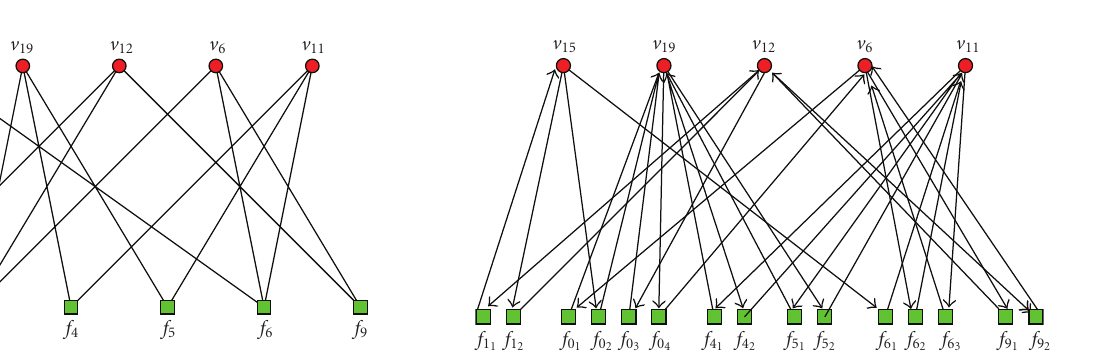
Figure 10: Subgraph of the Tanner graph with repeated check nodes and directed